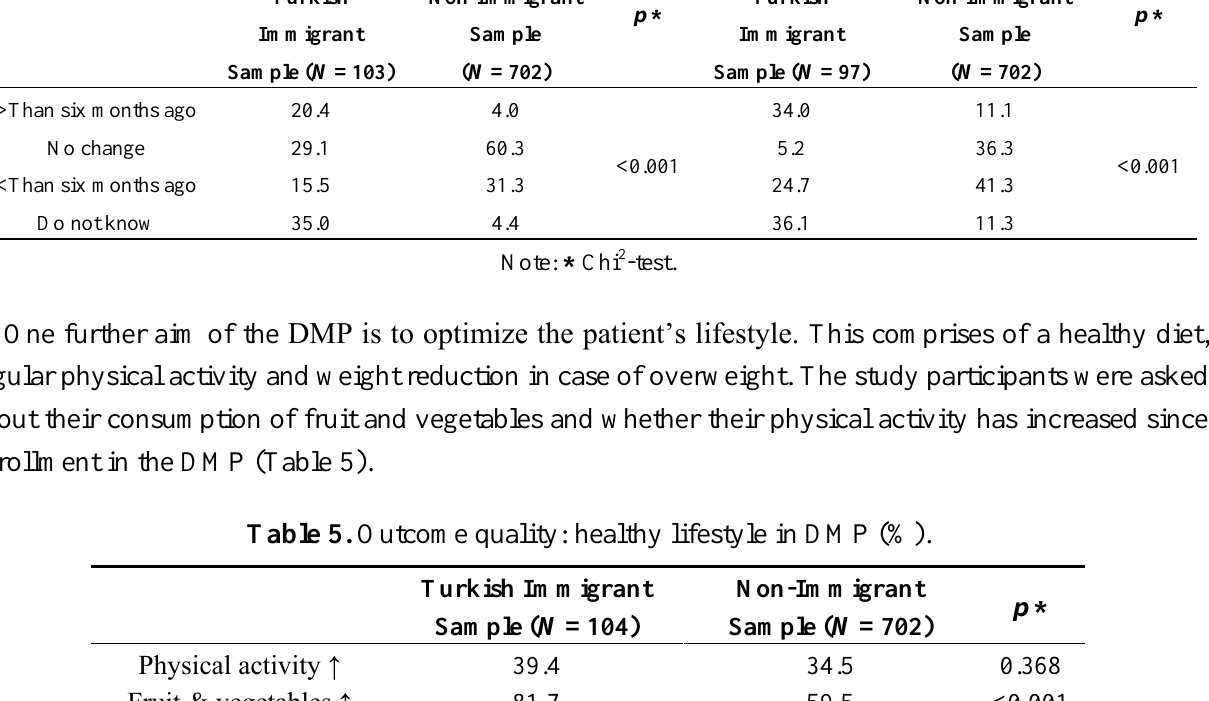
Table 4. Outcome quality: change in blood pressure and HbA